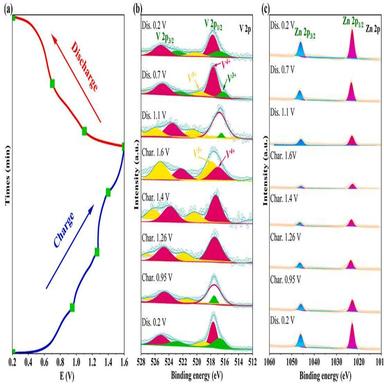
(a) Ex-situ high resolution XPS spectra of V 2p and Zn 2p at selected discharge/charges states of the V2O3@CCN-15/2 electrode.